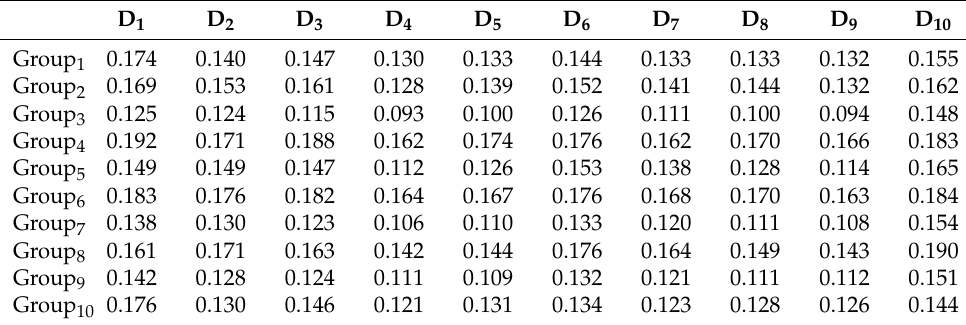
Table 9. Aggregated distances with Euclidean.